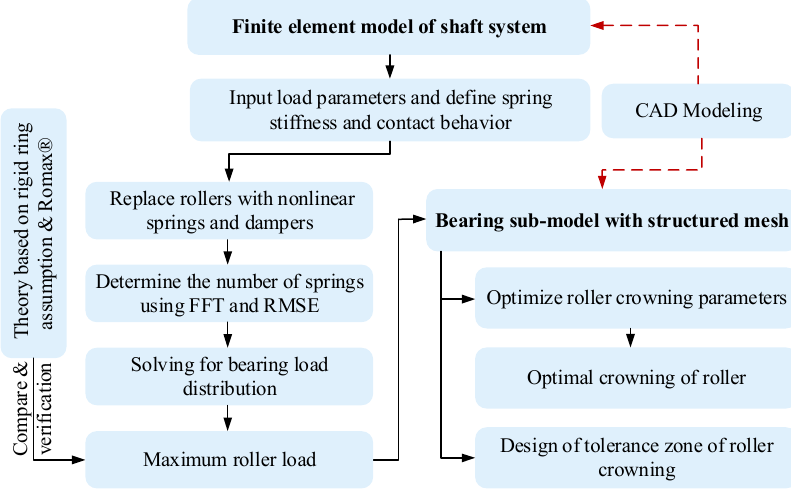
Figure 1. Design of logarithmic crowned roller for wind turbine spindle bearing.